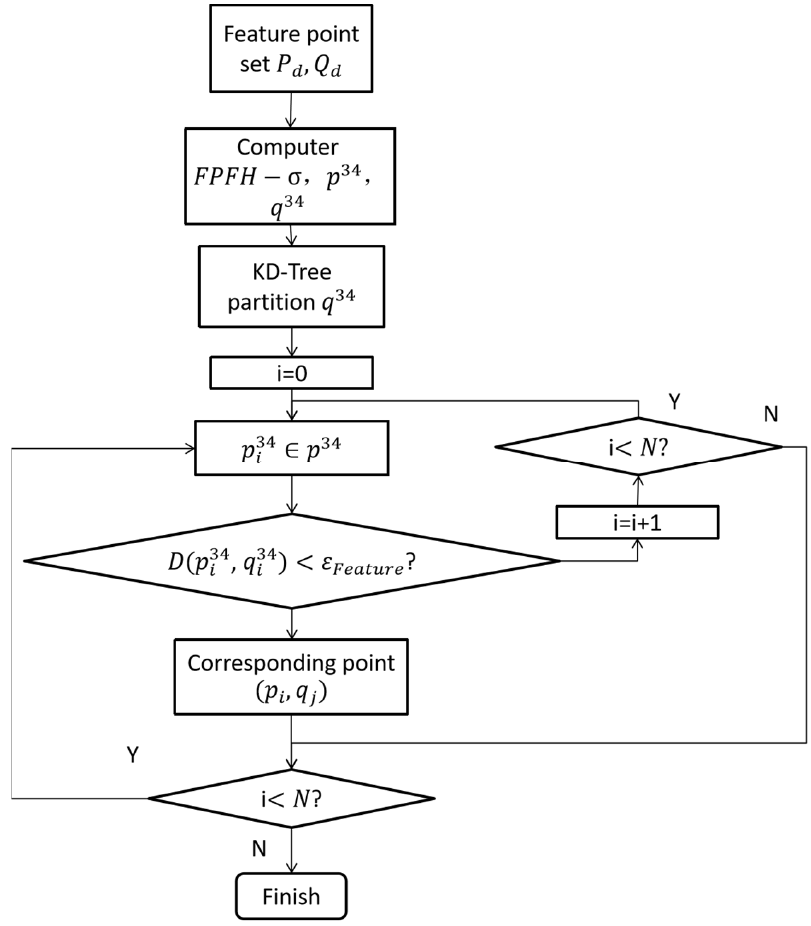
Figure 3. Feature matching process based on FPFH − σ